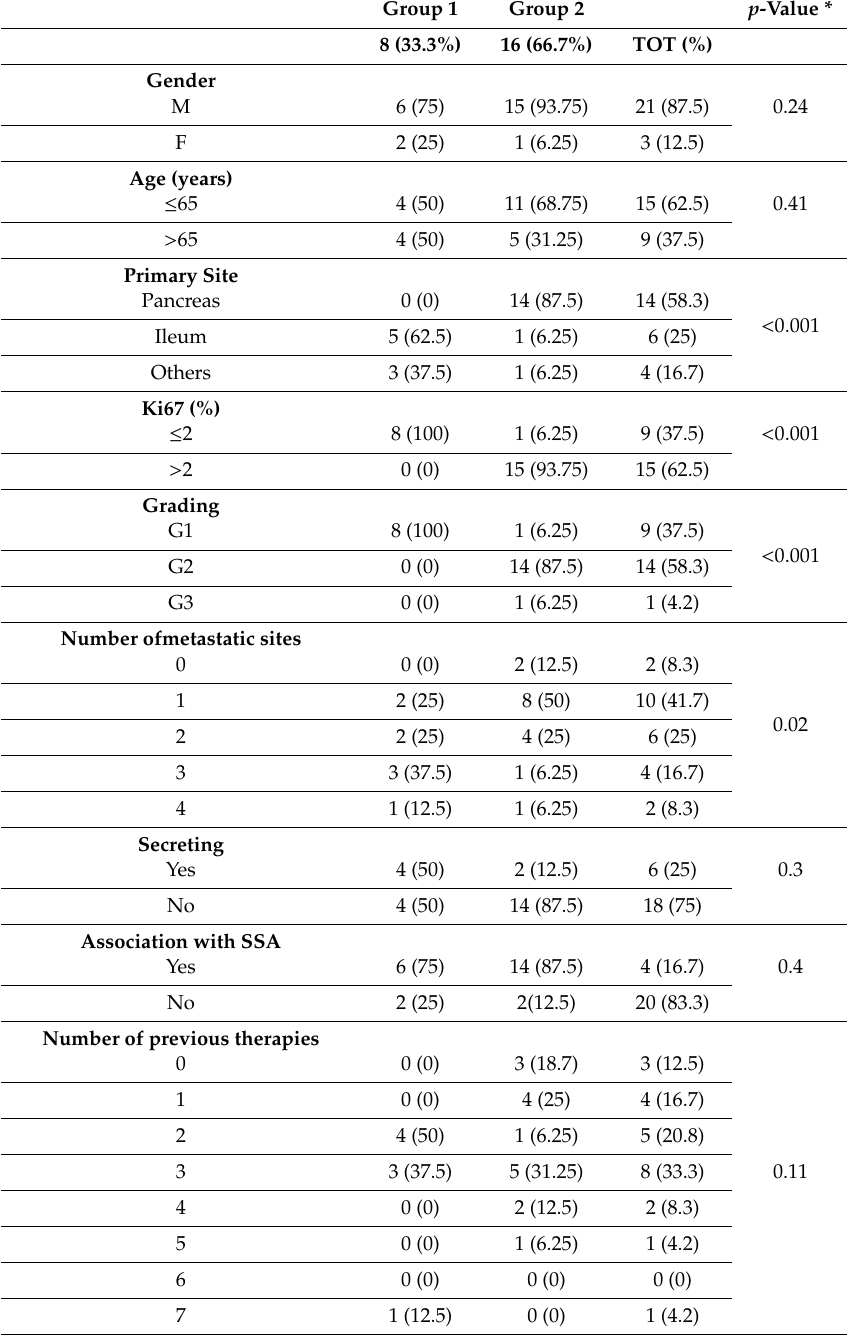
Table 1. Clinical-pathological